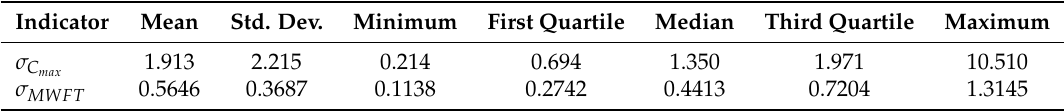
Table 3. Descriptive statistics for the spacing indicators based on 27